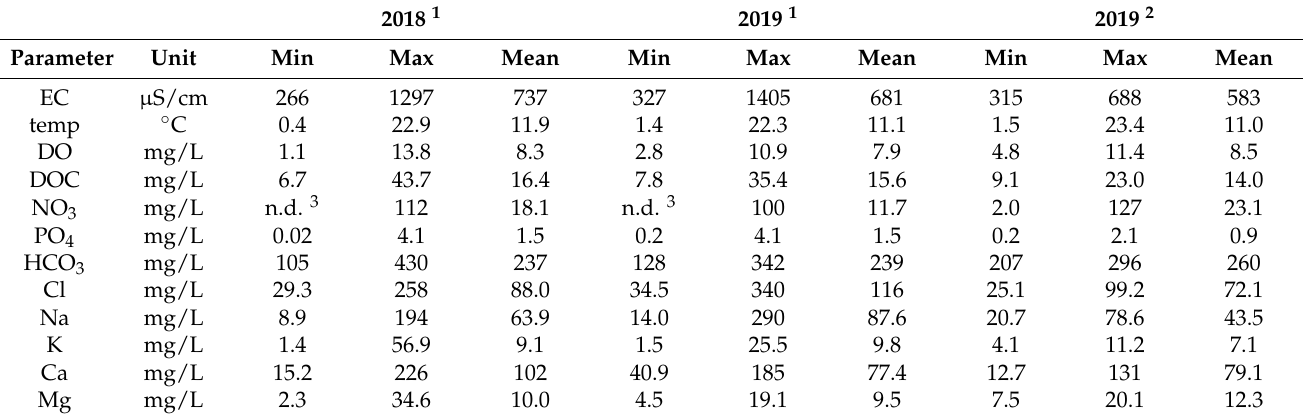
Table 1. Statistics of the parameters obtained for the Bzura River water